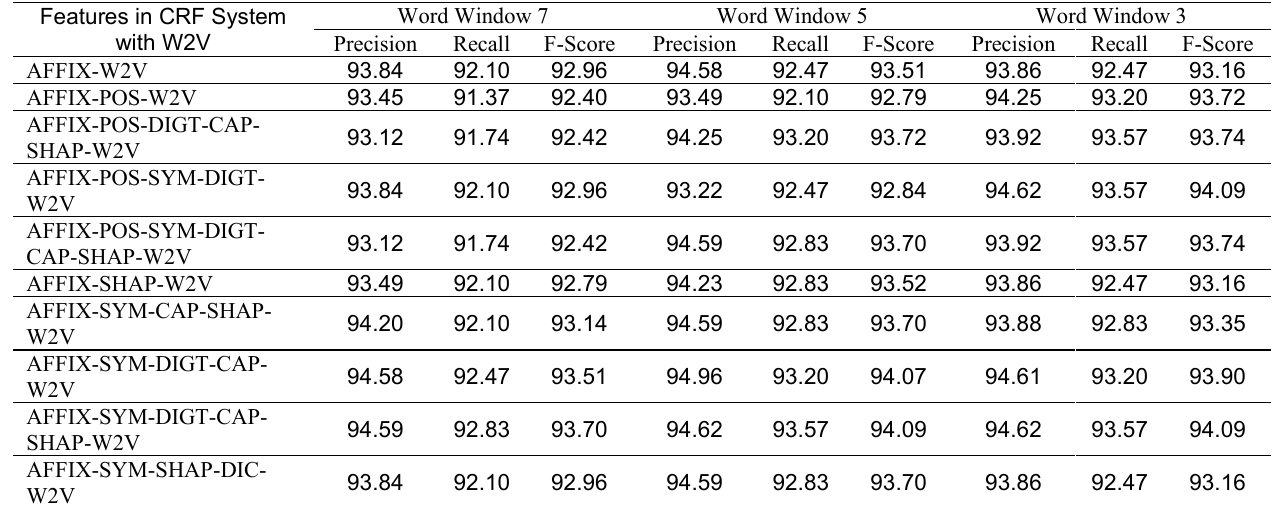
Table 4. Result of CRF Based NER System with Word Embedding